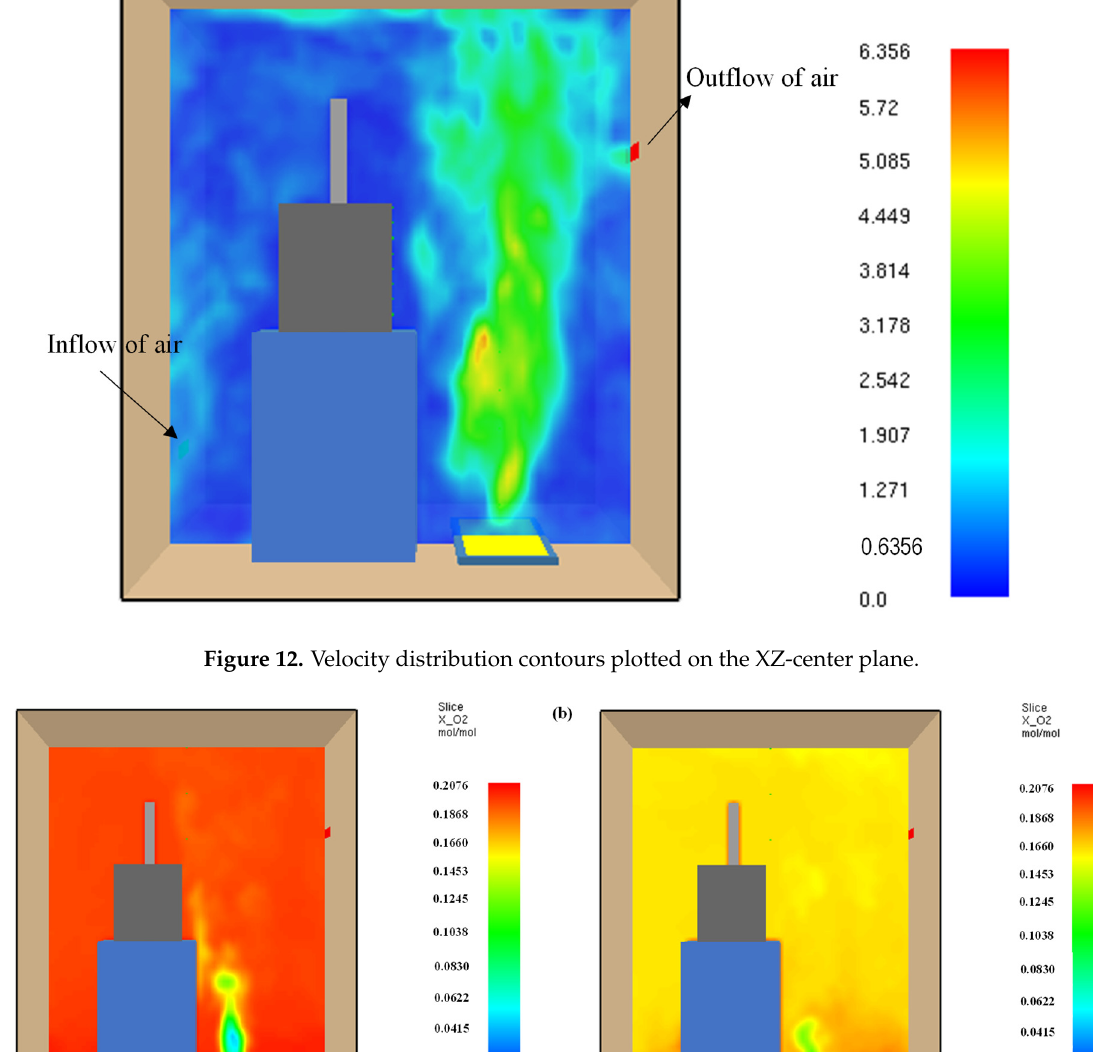
Figure 13. Oxygen concentration inside the enclosure on the room XZ center plane the ( a ) after 80 s and ( b ) after 500 s.